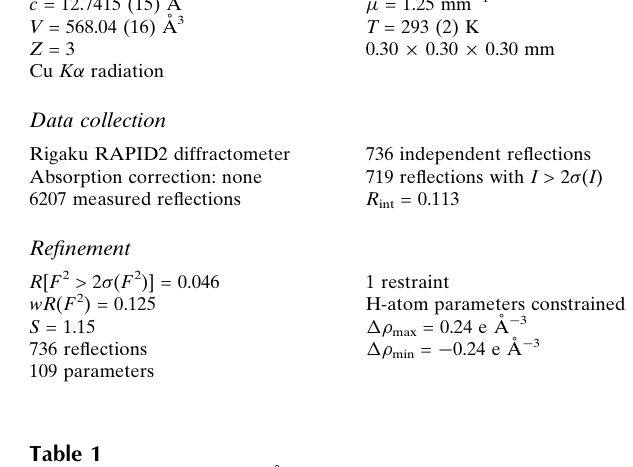
Hydrogen-bond geometry (A˚ , (cid:4)